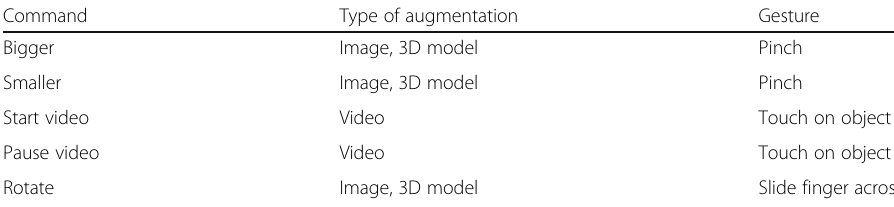
Table 1 Commands for interacting with augmentations Command Type of augmentation